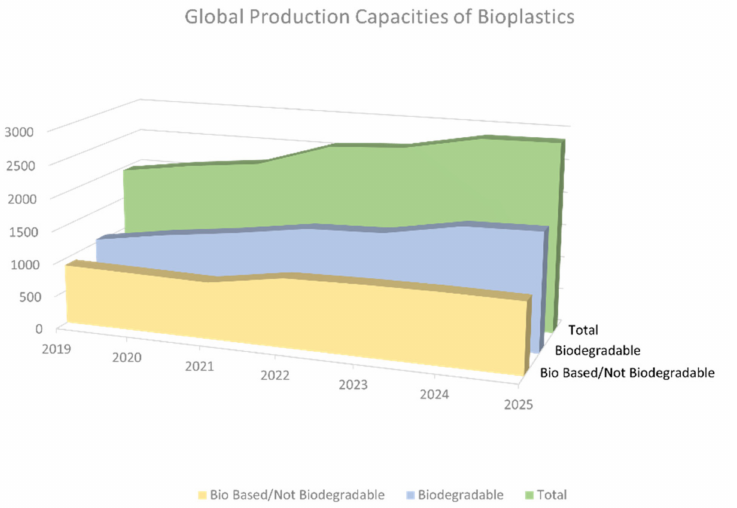
Figure 2. Projection of world global production capacity of bioplastics by 2024.